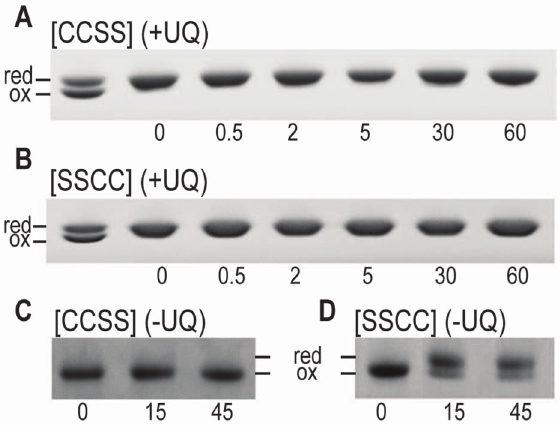
Figure 4. Redox states of wt a -DsbA1 in reaction with a -DsbB [CCSS] and [SSCC]. ( A ) a -DsbA1 was not oxidized in the presence of a -DsbB [CCSS] and UQ1; the first lane shows a reference sample comprising a mixture of reduced and oxidized wt a -DsbA1. ( B ) a -DsbA1 was not oxidized in the presence of a -DsbB [SSCC] and UQ1; the first lane shows a reference sample comprising a mixture of reduced and oxidized wt a -DsbA1. ( C ) Oxidized a -DsbA1 did not oxidize a -DsbB [CCSS] and hence remained oxidized in the presence of a -DsbB [CCSS]; ( D ) Oxidized a -DsbA1 oxidized more than 50% of reduced a -DsbB [SSCC] through thiol-disulfide exchange with reduced a -DsbB [SSCC], yielding significant amount of reduced a -DsbA1. Data shown are representative of two replicates.